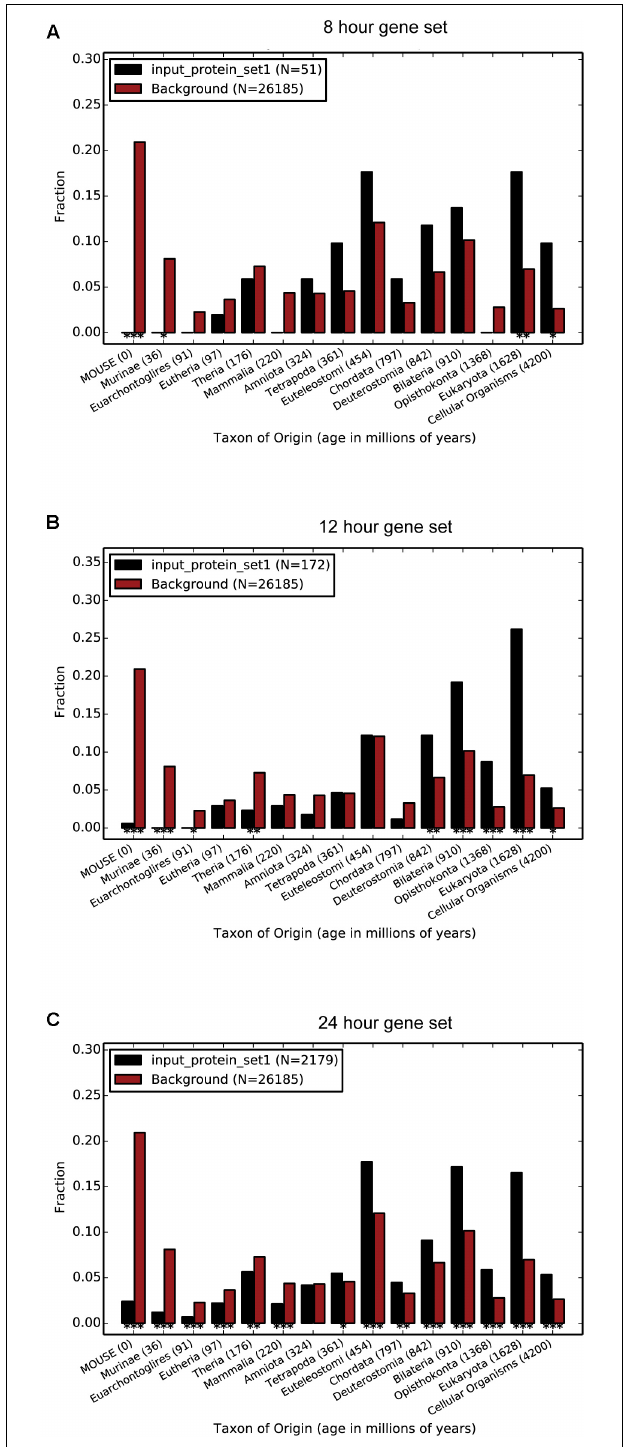
FIGURE 1 | The evolutionary age of the oscillating gene subsets differs significantly. The 12 h oscillating gene subset shows the highest average age. The 8 h (A) oscillating gene subset has an average age of 1117 million years, the 12 h; (B) oscillating gene subset has an average age of 1143 million years and the 24 h; (C) oscillating gene subset has an average age of 973 million